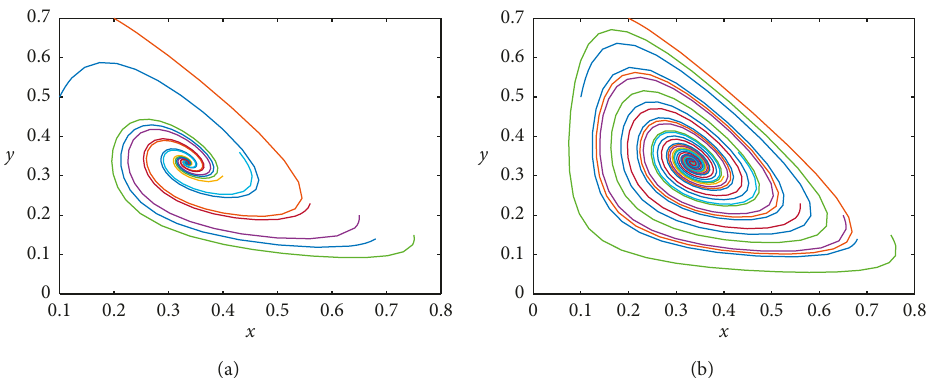
Figure 4: The interior equilibrium’s changing situation with the same c and different μ . (a) c � 1 . 5and μ � 0 . 02. (b) c � 1 . 5and μ � 0 .